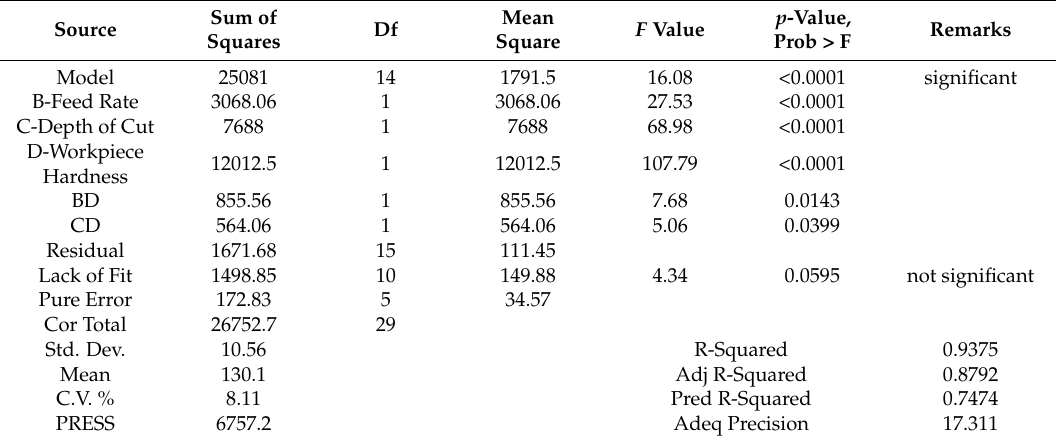
Table 13. Model of Thrust Force for CBN-III